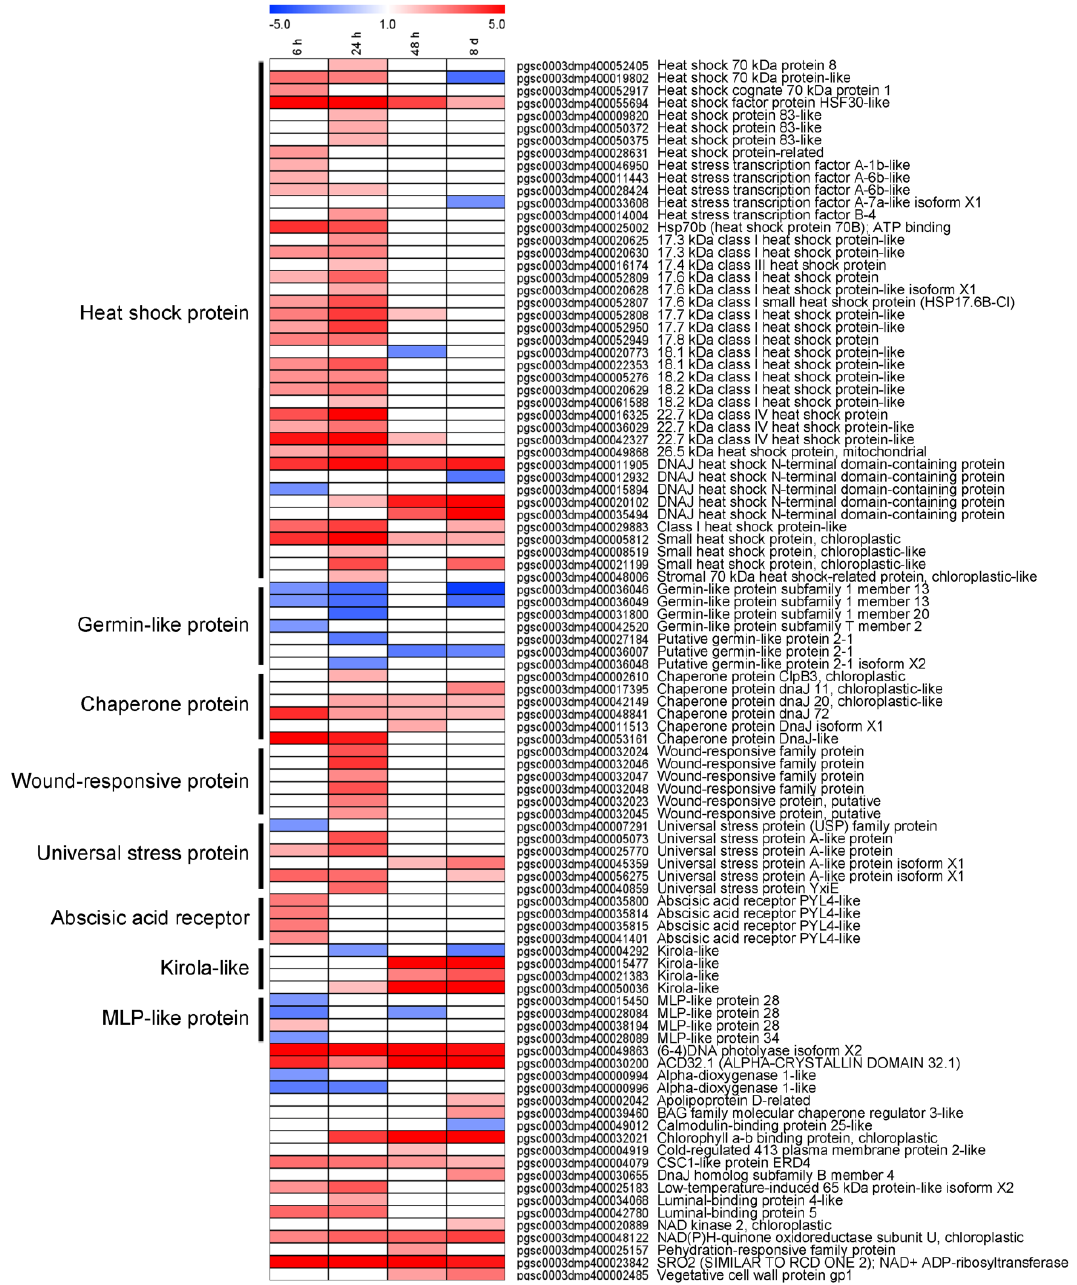
Figure 5. Heat map showed transcriptional profiles of abiotic-related DEGs, which included heat shock proteins, germin-like proteins, chaperone proteins, wound-responsive proteins, universal stress proteins, Abscisic acid receptors, Kirola-like proteins, and MLP-like proteins. Bins in red are significantly up-regulated; bins in blue are significantly down-regulated.